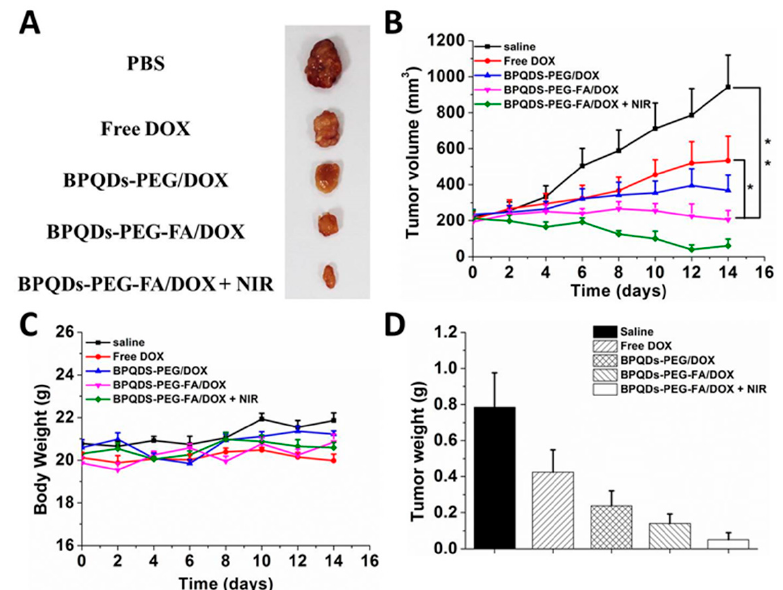
Figure 8. In vivo chemo-photothermal synergistic therapy. ( A ) Representative photos of excised tumors after 14 days of treatments. ( B ) Tumor growth curves of different groups of tumor-bearing mice after treatments. ( C ) The changes of body weight of tumor-bearing mice after treatments. ( D ) Tumor weight of each group taken out from the sacrificed mice at the end point of research ( n = 3, * p < 0.05, ** p < 0.01).